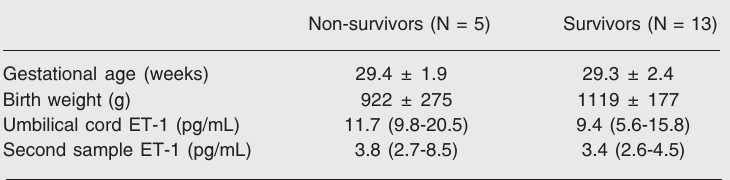
Data are reported as mean ± SD and median (p25-p75). There were no statistical differences by the Student t -test and the Mann-Whitney test between